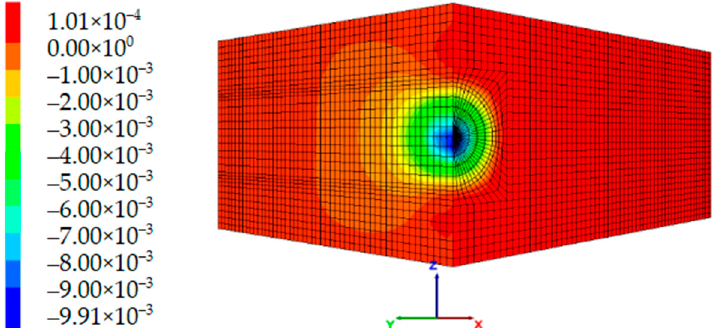
Figure 12. The y-direction displacement contour on the longitudinal section of the tunnel with the real reinforcement method (unit: m).